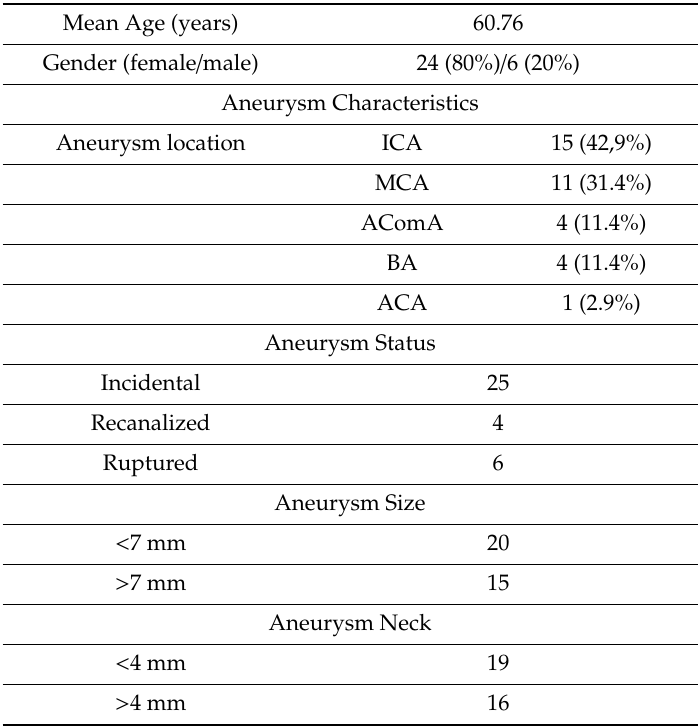
Table 1. Patients’ characteristics.